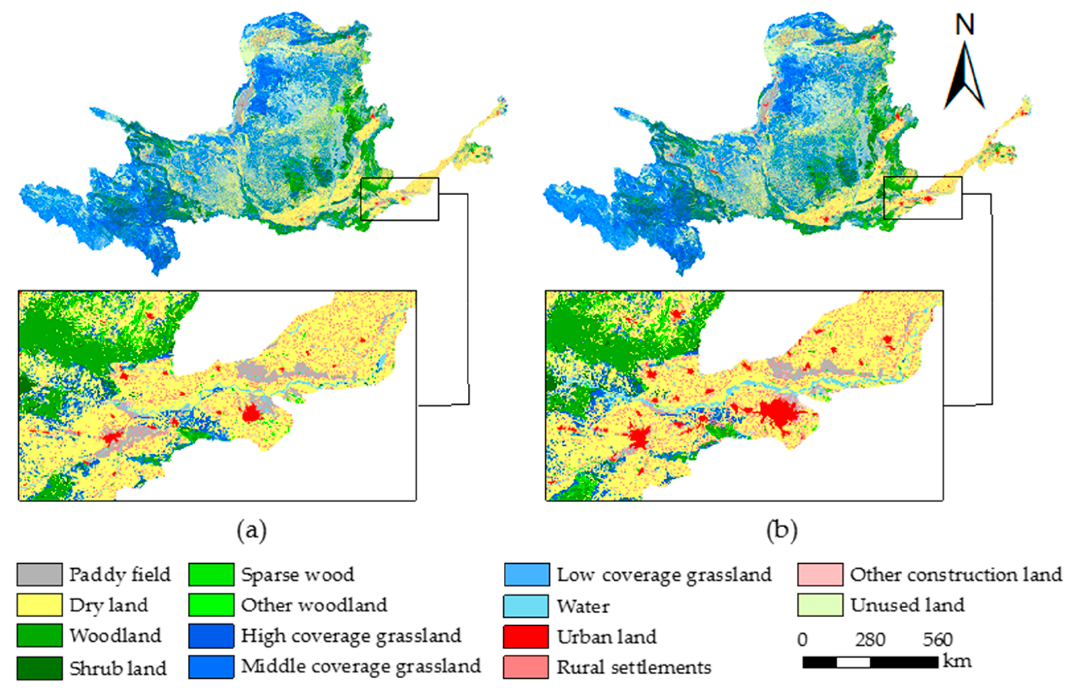
Figure 4. Spatial distribution of land use type in Yellow River Basin: ( a ) 2000 and ( b ) 2020.